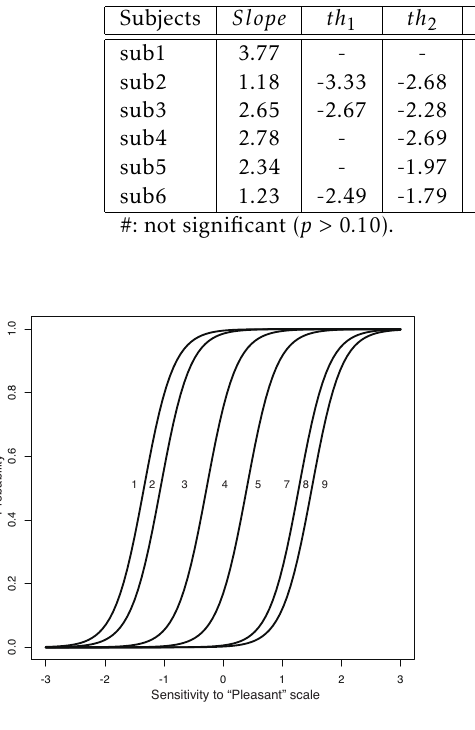
Figure 5. As all peaks for curves show rating values,